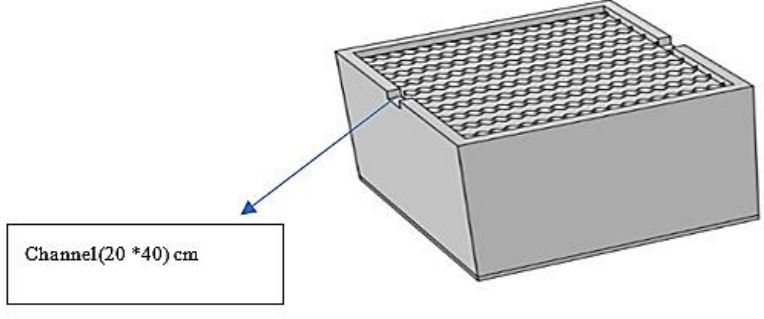
Figure 1. A. physical models of the room